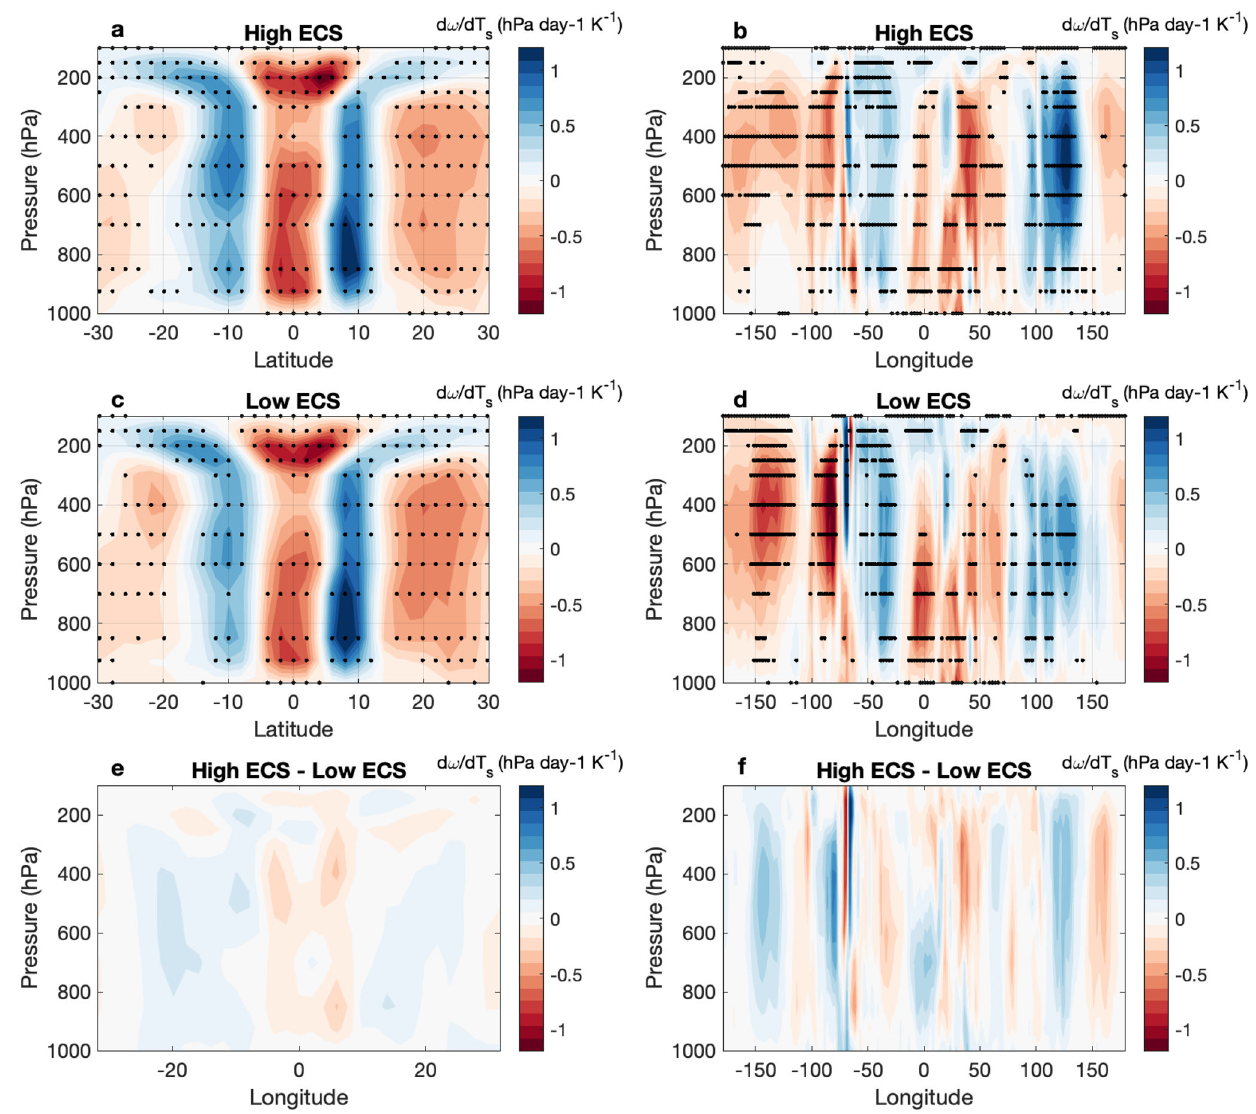
Fig. 3 | Subsidence generally weakens more in models with a lower climate sensitivity than in models with a higher climate sensitivity. Zonal ( a , c , e ) and meridional( b , d , f )meancomposites(30°S-30°N)ofthechangeinpressurevelocity ( ω ; hPa day − 1 K − 1 ) per degree of surface warming (d ω /dT s ) for ( a , b ) high climate